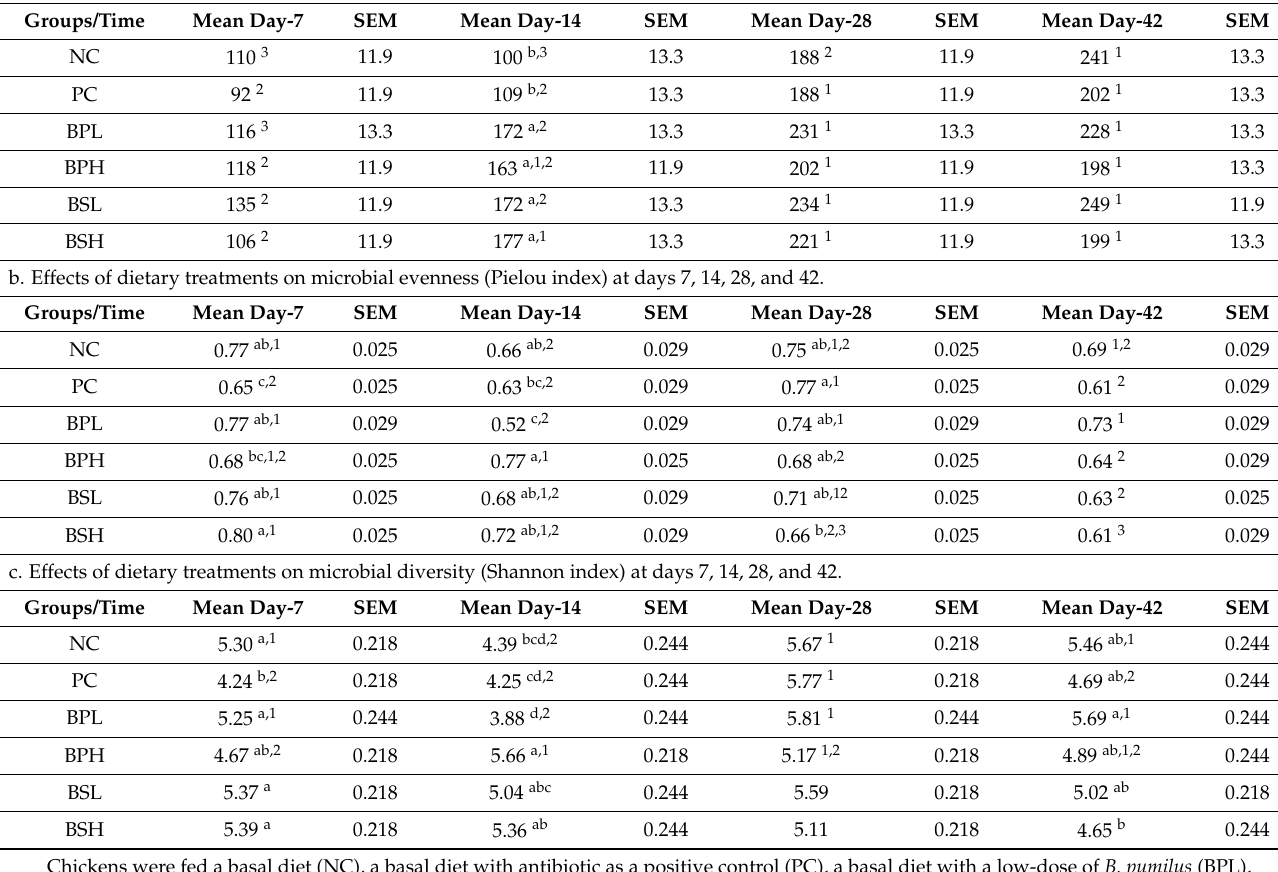
Table 1. Effects of dietary treatments on microbial richness ( a ), evenness ( b ), and diversity ( c ) in broiler chickens at days 7, 14, 28, and 42 of